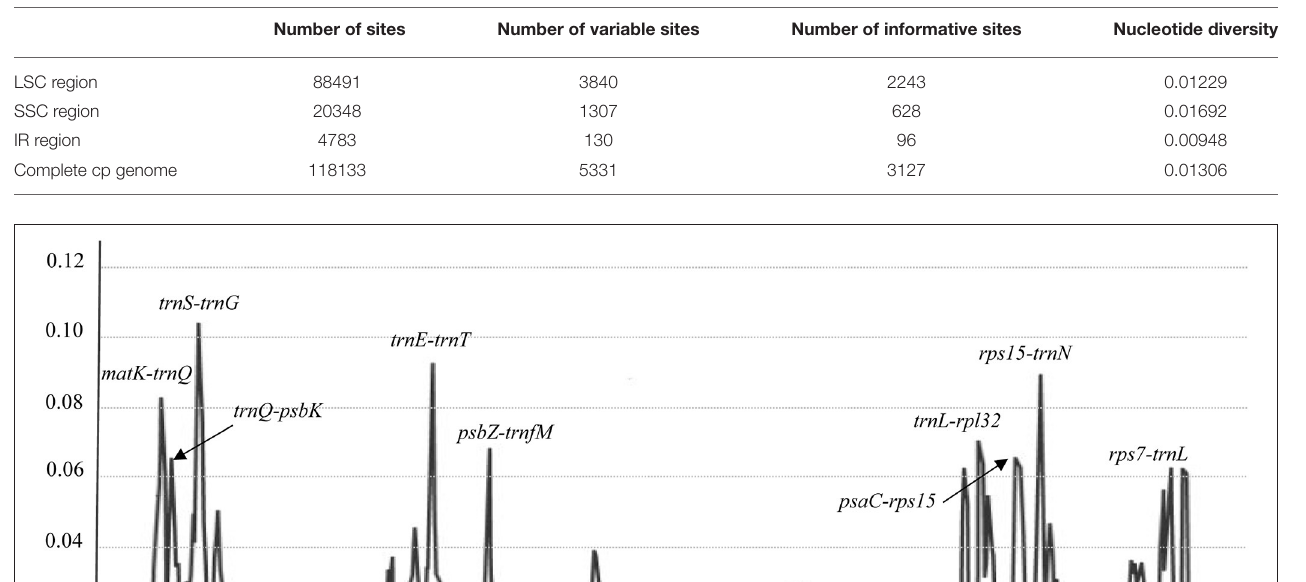
TABLE 4 | Analyses of variable sites in cp genomes of Zygophyllum .